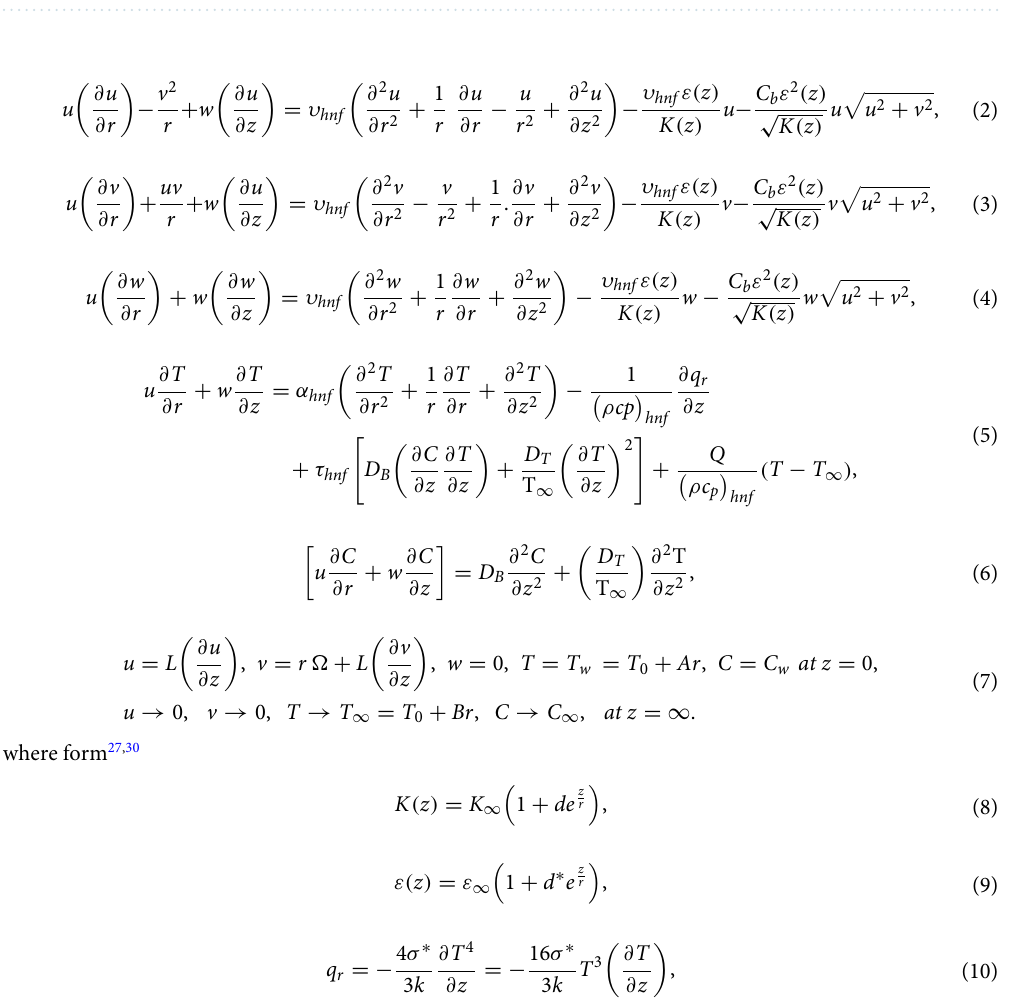
Figure 1. The schematic layout of 3-dimensional